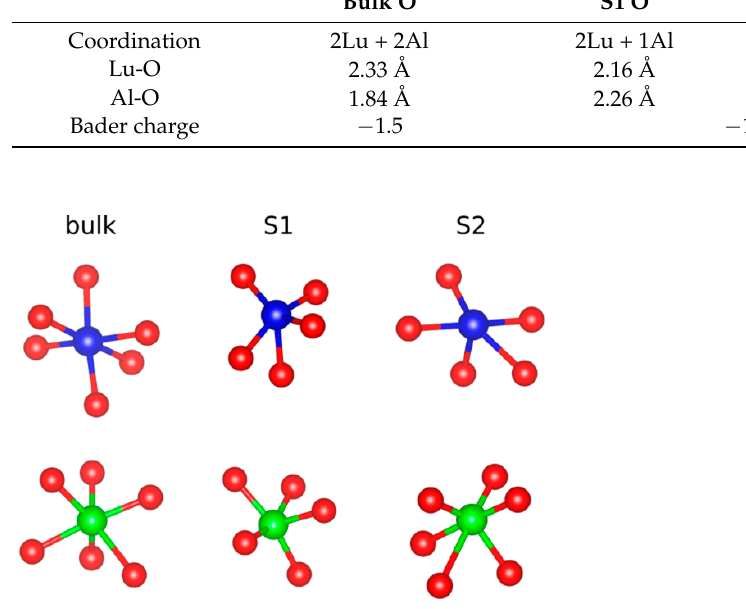
Figure 3. Local structure for the antisites (Lu Al ) in the bulk and on the surfaces. The Lu, Al, and O atoms are shown in blue, green, and red. Table 3. The calculated structure data of antisite defects Lu Al and Al atoms.